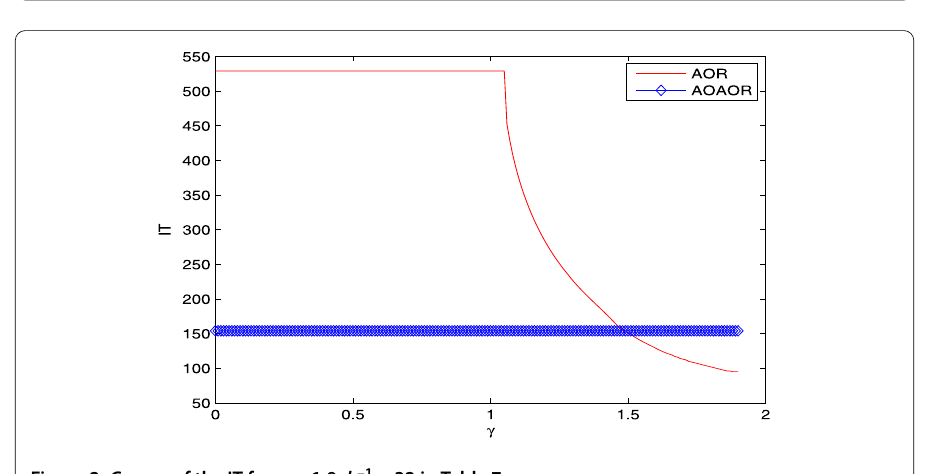
Figure 2 Curves of the IT for ω = 1.9, h –1 = 32 in Table 7.